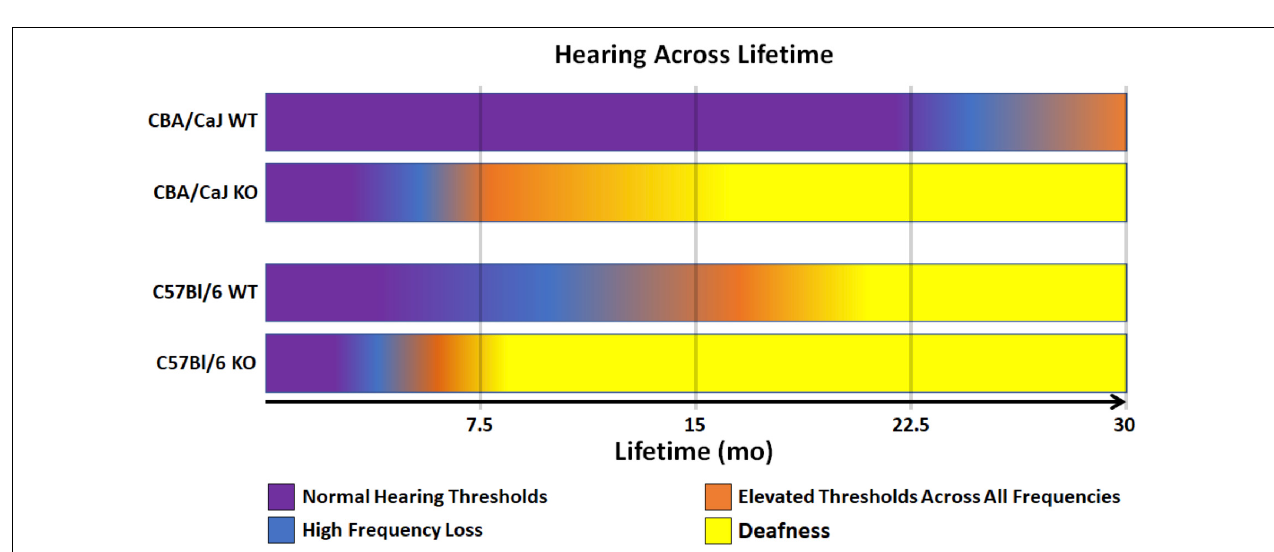
FIGURE 3 | Model of WT and KO hearing spans in CBA and C57 backgrounds. Comparison of changes in hearing outputs after OCM loss across a 30-mo average lifetime. CBA WT mice show high frequency loss after 20 mo (magenta). CBA KO mice show high frequency loss in less than half the time (5 – 7 mo) which is earlier than when the C57 WT mice lose high frequencies (7 – 10 mo). C57 KO mice lose high frequencies at 3 – 4 mo. Deafness (yellow) is defined as maximum elevation of DPOAE thresholds at all frequencies tested (5.6 – 45.2 kHz